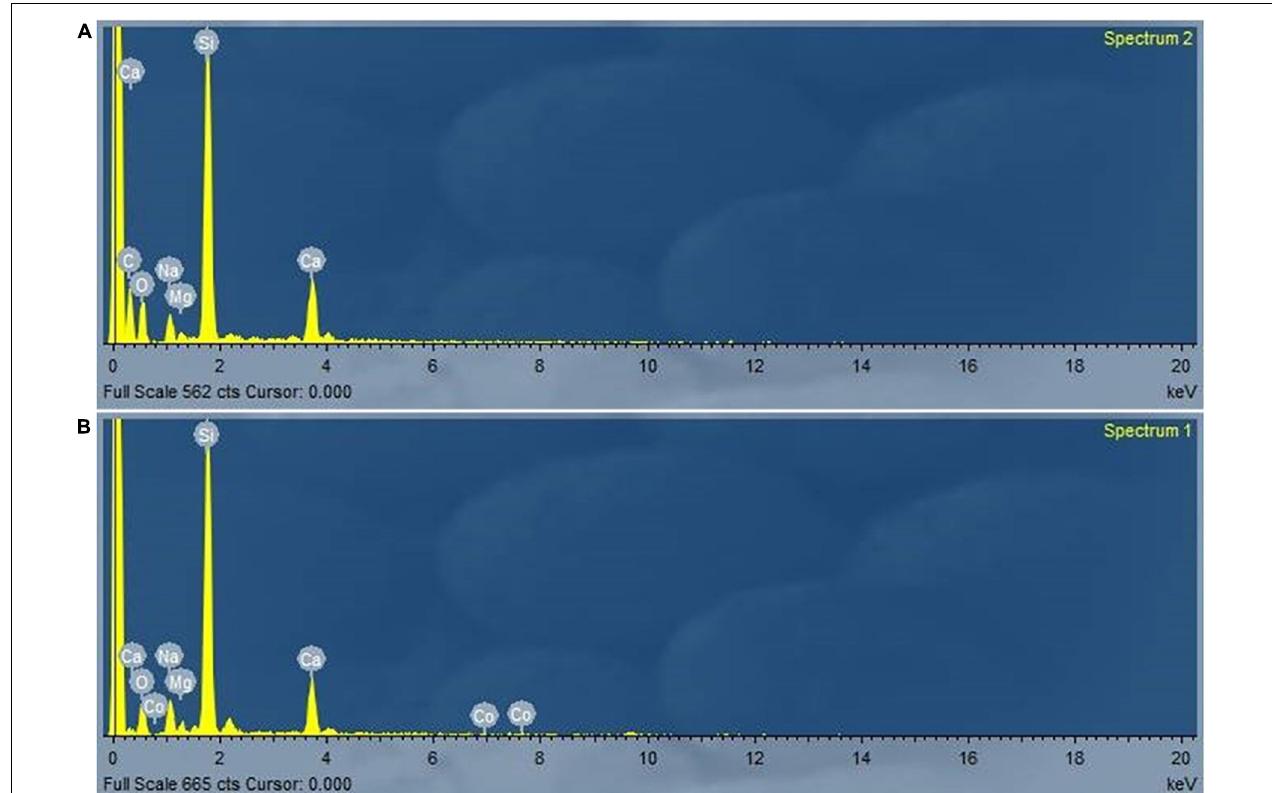
FIGURE 7 | Analysis of electron dispersive spectroscopy of P . alcaliphila NEWG-2 presents the normal cell element before (A) treatment in comparison with the emerging peak of Co (II) ions after (B) the biosorption